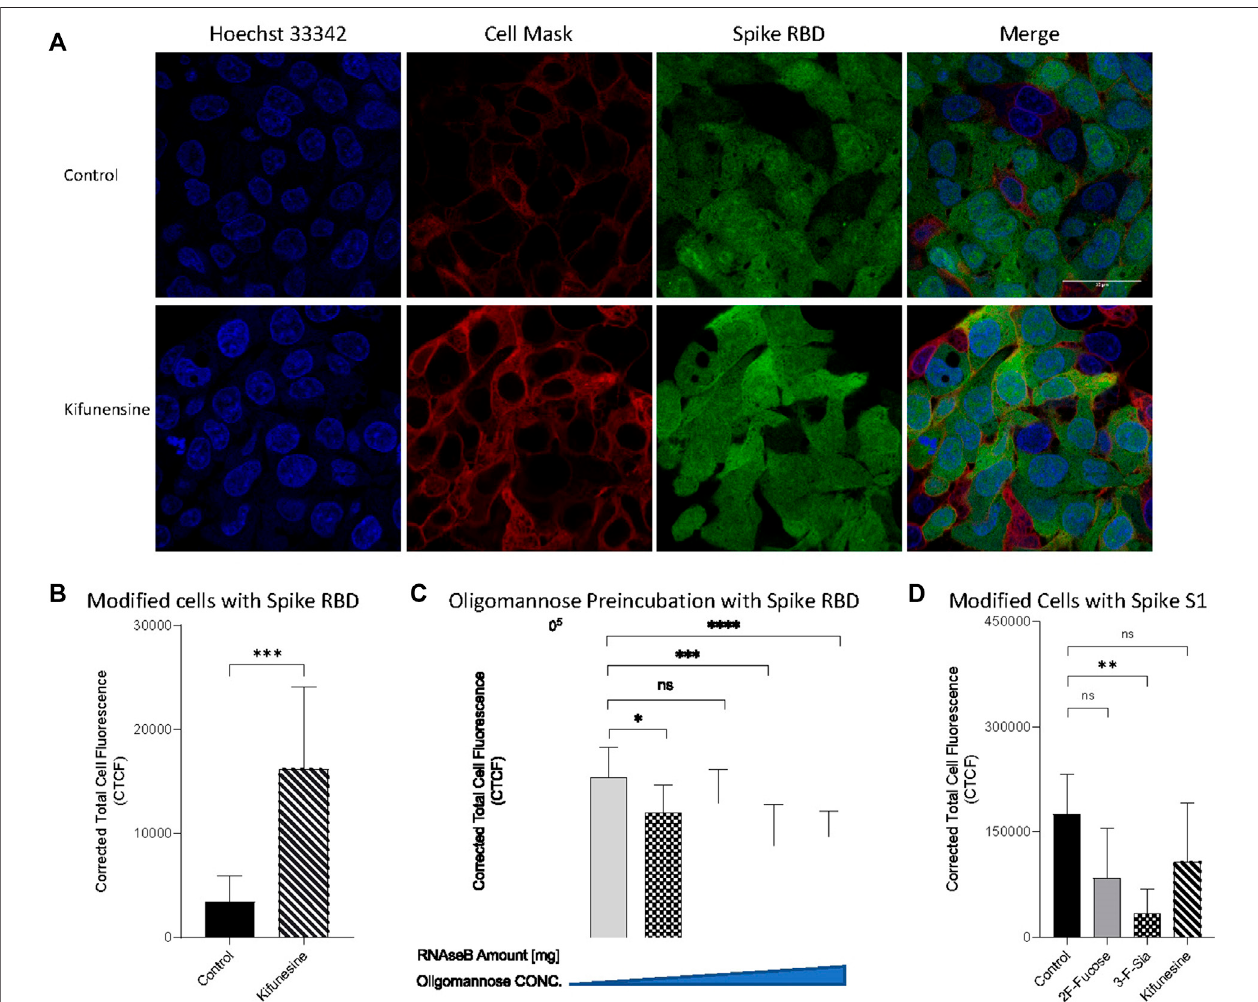
FIGURE 7 | Introducing high mannose glycans into viral binding. (A) Immuno fl uorescence for S protein RBD binding with modi fi ed cells. The columns (from left to right)showstainingofnuclearacid(Hoechst33342),plasmamembrane(CellMask ™ DeepRed),SproteinRBD,andmergedimage.Scalebar,600pixels.Quanti fi cation of fl uorescent intensity of spike protein RBD (B , C) or S1 subunit (D) binding. (C) Fluorescent labelled proteins were preincubated with puri fi ed high mannose at room temperature for 30 min before binding. Fluorescence intensity was quanti fi ed for selected cell area. Quanti fi cation was performed with software ImageJ. Asterisks indicate the statistical signi fi cance between groups compared (* p < 0.05%; ** p < 0.01%; *** p < 0.001%; **** p < 0.0001%; ns p <